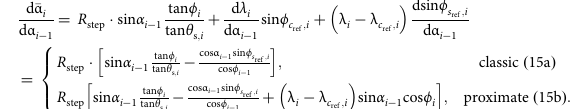
heading 2,10,30 .